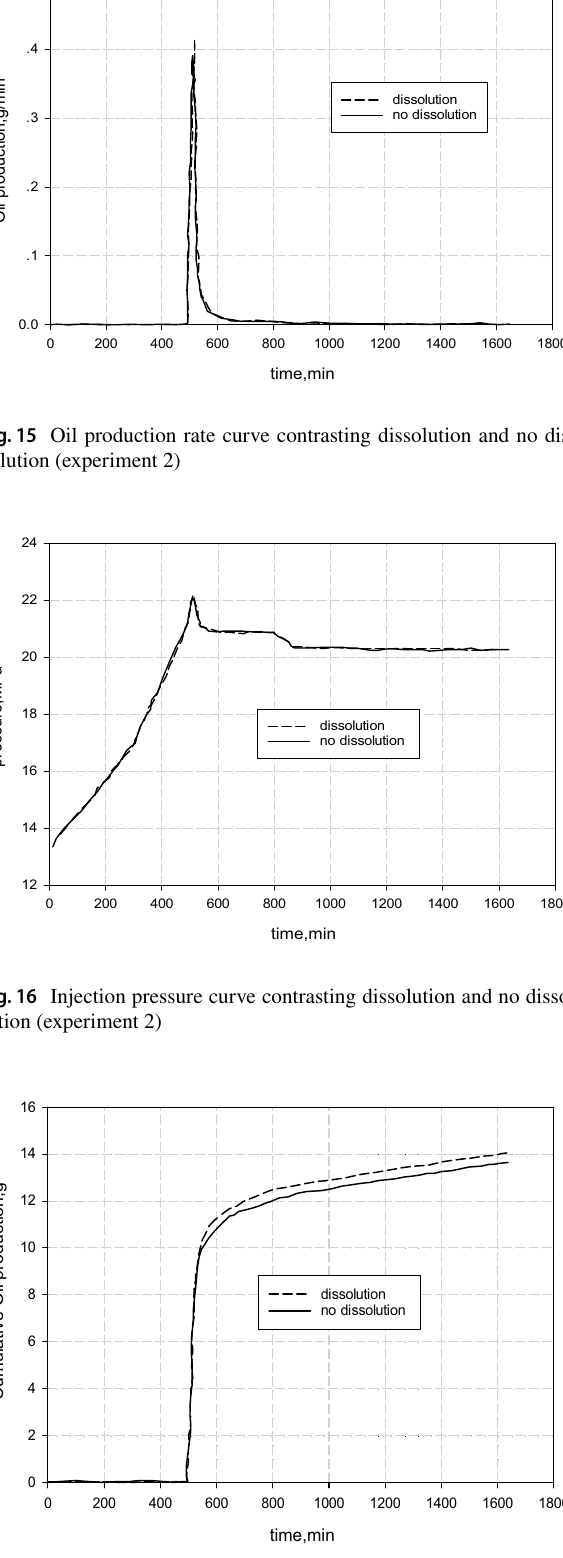
Fig. 17 Cumulative oil production curve contrasting dissolution and no dissolution (experiment